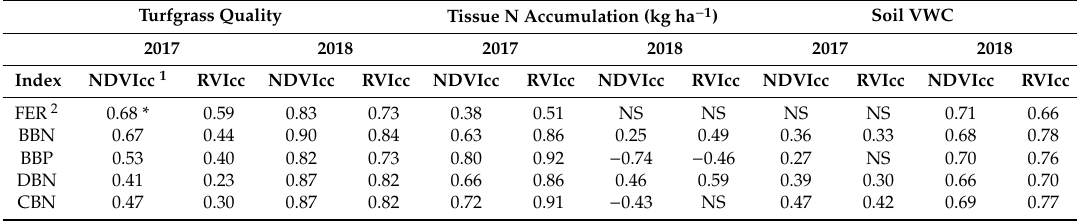
Table 9. Pearson correlation coe ffi cients ( r ) between turfgrass quality, leaf tissue N accumulation, soil volumetric water content (VWC), and vegetation indices derived from traditional multispectral Crop Circle ACS-430 of tall fescue grown under five di ff erent fertility amendments in Blacksburg, VA. Turfgrass Quality Tissue N Accumulation (kg ha − 1 ) Soil